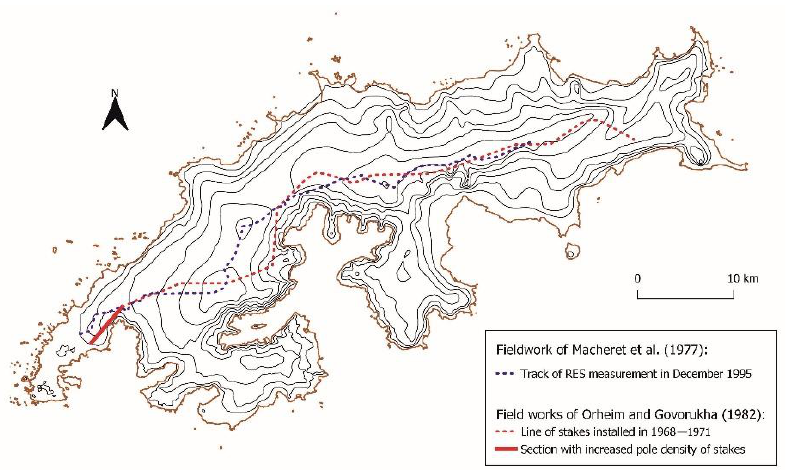
Figure 4. Track of RES measurements obtained in December 1995 by Macheret et al. [49] and the line of stakes obtained by Orheim and Govorukha [26].